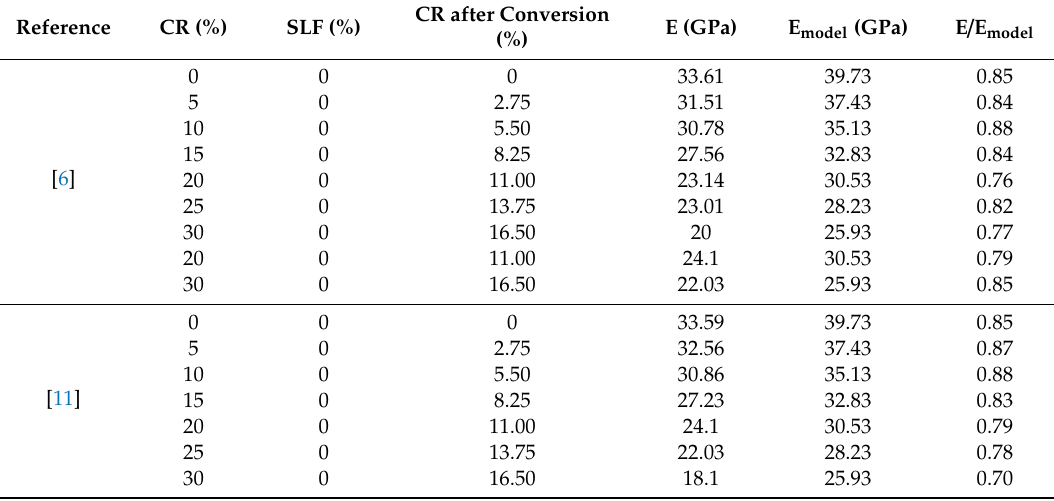
Table 13. Verification of the prediction model for modulus of elasticity